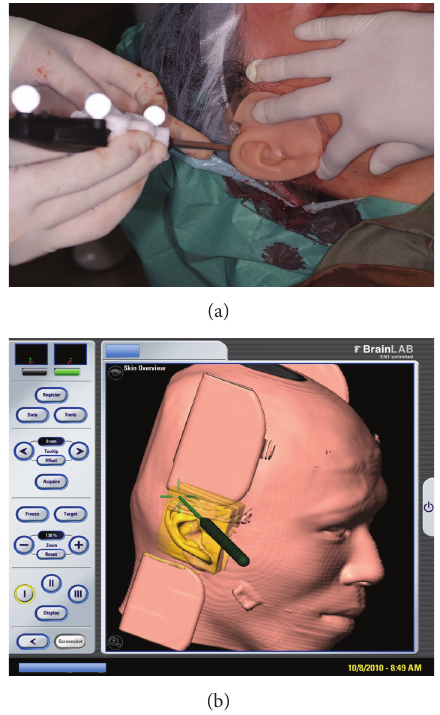
Figure 2: (a) Prosthesis position checked with Soft Touch (Brain- LAB) digitized probe. (b) Screen shot of checking of the prosthesis position using the Soft Touch digitized probe to compare with preplanned position intraoperatively.